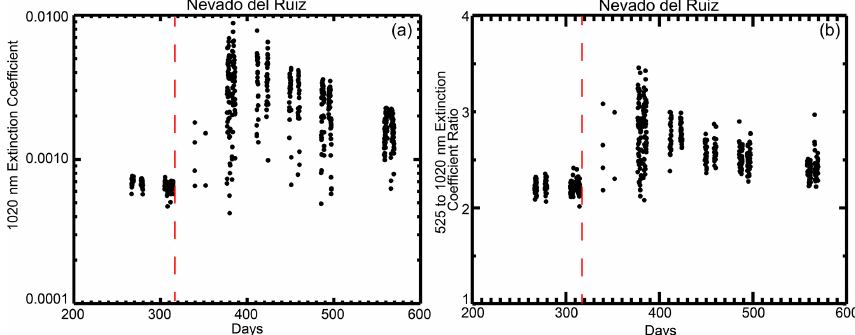
Figure 4. The time series of the SAGE II 1020nm aerosol extinction coefficient (in km − 1 ) (a) and the 525 to 1020nm aerosol extinction coefficient ratio (b) at 20.5km between 10 ◦ S and 10 ◦ N in days from 1 January 1985 (Day 1); thus, the first day is 19 July 1985, the eruption occurs on Day 317 (13 November 1985), and the plot ends on 23 August 1986. The date of the eruption is denoted by a vertical dashed red line.